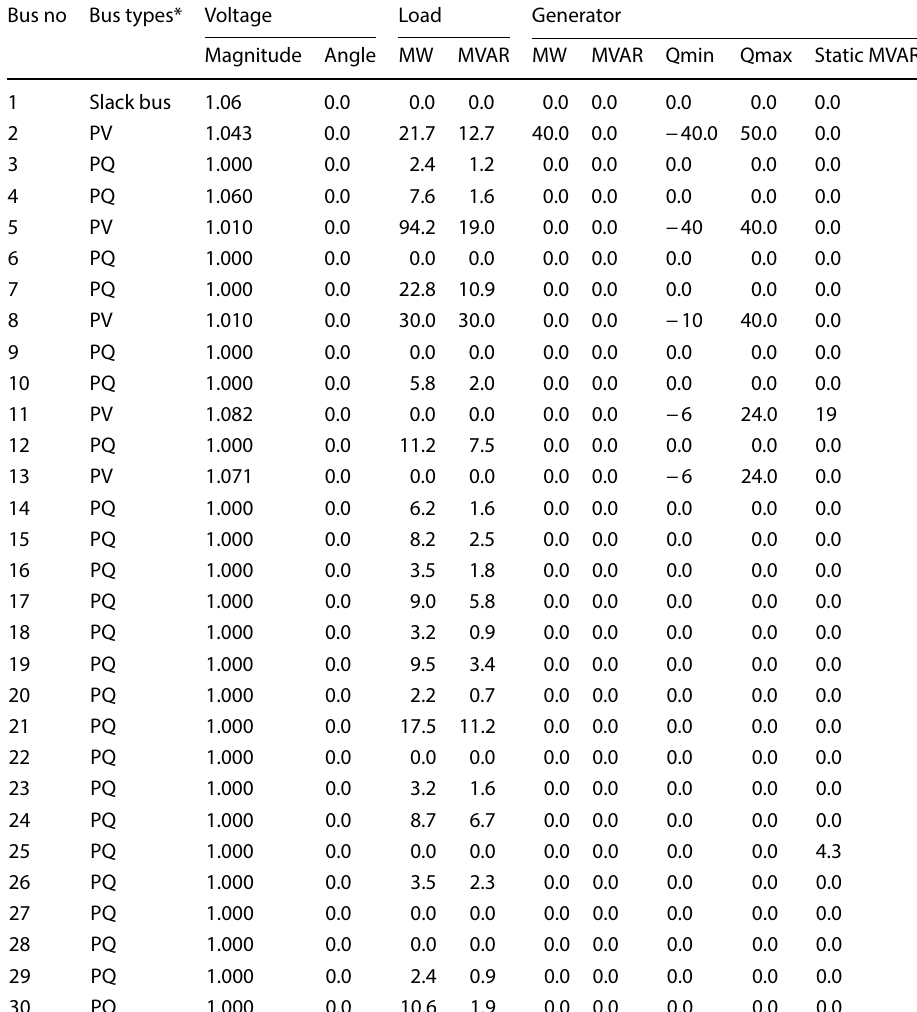
Table 13 IEEE 30 bus busdata